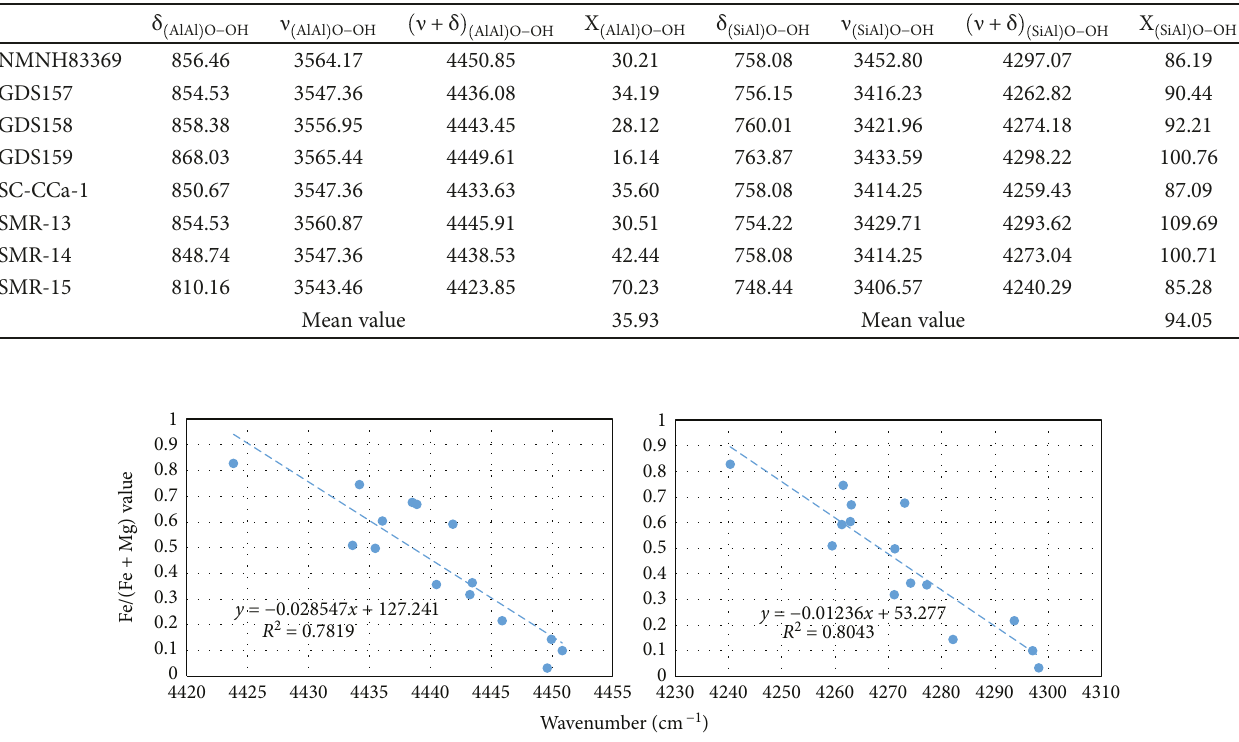
δ ν + δ OH , OH , and OH bands observed for chlorites from the USGS spectral library and calculated